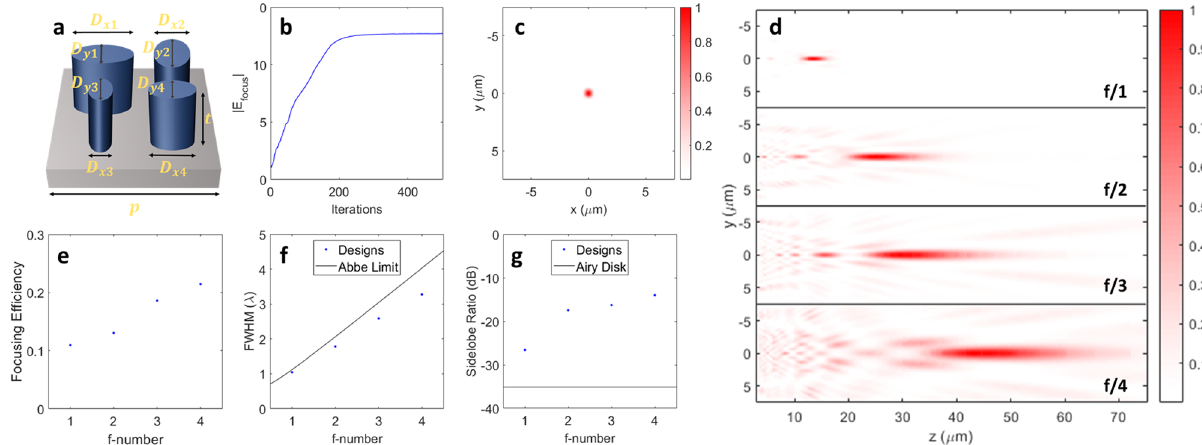
Fig. 5 Optimization results for metalenses. a The unit cell is based on four coupled TiO 2 elliptical nanopost resonators, each de fi ned by their respective major and minor axes. The labels D xi and D yi denote the x and y semi-diameters of the i th nanopost of the four resonators in the unit cell, respectively. The labels t and p denote the thickness and pitch of the unit cell. An example learning curve where we optimize the electric fi eld magnitude at the desired focal spot, | E focus |, is shown in ( b ) and its corresponding normalized intensity pro fi le computed via fi nite-difference time-domain (FDTD) simulation at the focal plane is presented in ( c ). Normalized intensity cross sections along the optical axis for several different optimized metalenses with different f-numbers, with the near- fi eld data computed via FDTD, are shown in ( d ). Focusing ef fi ciency ( e ), FWHM at best focus ( f ), and the peak sidelobe ratio ( g ) are calculated from the FDTD-simulated optimized designs of ( d